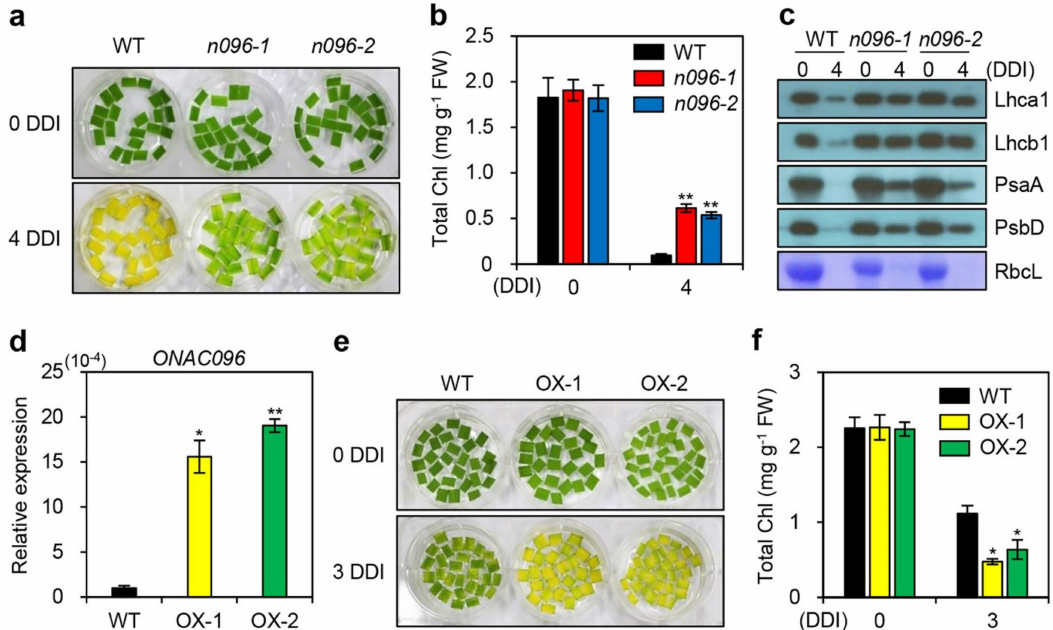
Figure 3. ONAC096 accelerates leaf yellowing during dark-induced senescence. ( a – c,e,f ) Detached leaves of 3-week-old plants were incubated in 3 mM MES bu ff er (pH 5.8) in complete darkness at 28 ◦ C. Leaf yellowing ( a ) and total chlorophyll contents ( b ) were monitored in onac096 at 0 and 4 days of dark incubation (DDI). ( c ) Immunoblotting of detached leaves from WT and onac096 plants at 0 and 4 DDI using antibodies against photosynthetic proteins (Lhca1, Lhcb1, PsaA, and PsbD). ( d ) Expression of ONAC096 measured in the leaves of ONAC096 -OX plants (OX-1 and OX-2) grown in a growth chamber for 3 weeks under long-day conditions. ONAC096 transcript levels were measured by RT-qPCR and normalized to that of OsUBQ5 . Relative expression was calculated using the ∆∆ C T method. ( e,f ) The detached leaves of ONAC096 -OX plants exhibited accelerated leaf yellowing ( e ) and reduced total chlorophyll levels ( f ) at 3 DDI. ( b,d,f ) Mean and standard deviations were obtained from three biological repeats. Asterisks indicate statistically significant di ff erences between onac096 ( b ) and ONAC096 -OX plants ( d,f ) compared to the WT at 4 and 3 DDI, respectively, according to Student’s t -test (* p < 0.05 and ** p < 0.01). The experiments were repeated twice with similar results. Chl, chlorophyll; FW, fresh